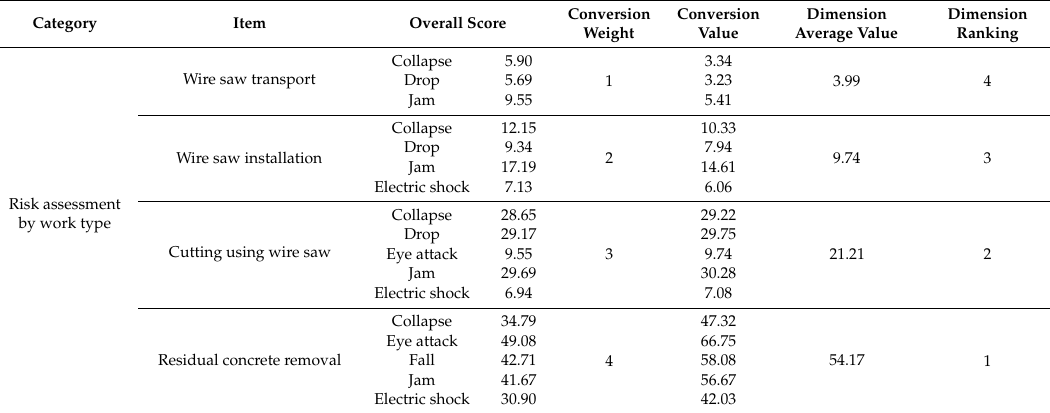
Table 11. Risk calculation